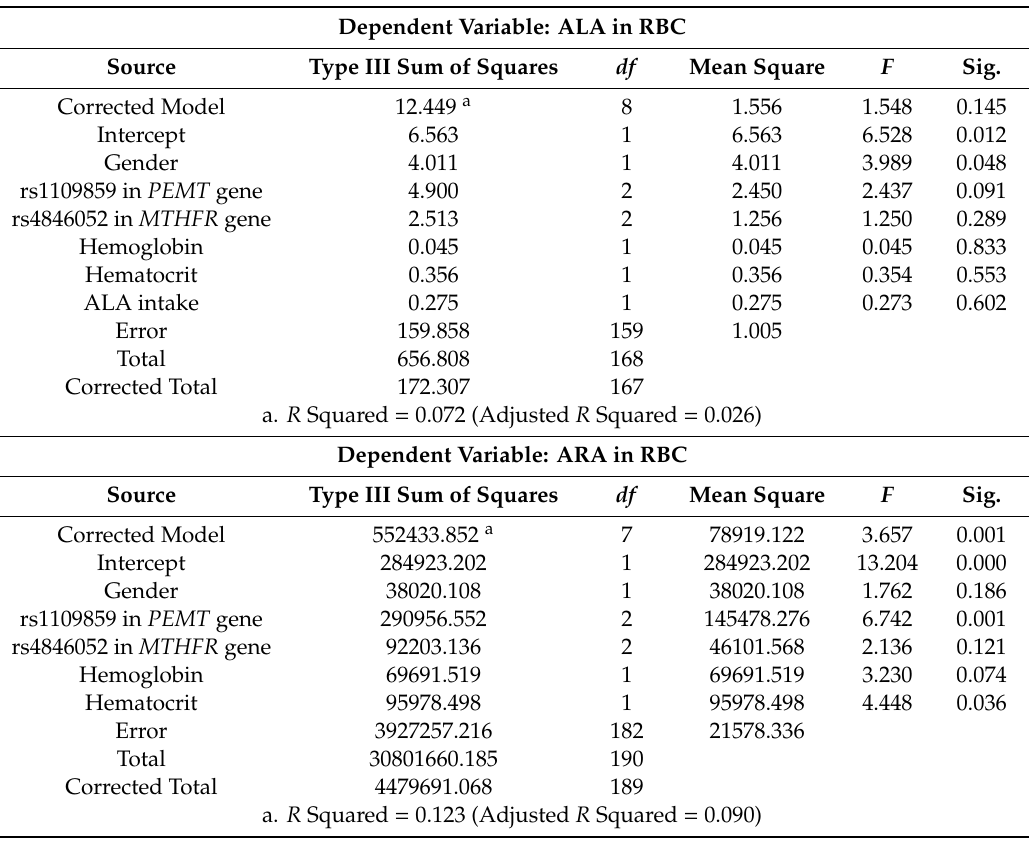
Table A4. Univariate analysis of variance results. Models were created using the PUFA RBC levels as dependent variables; gender, genotypes rs1109859, and rs4846052 as fixed factors, and dietary intakes, hemoglobin, and hematocrit as covariates. Test is significant at p ≤